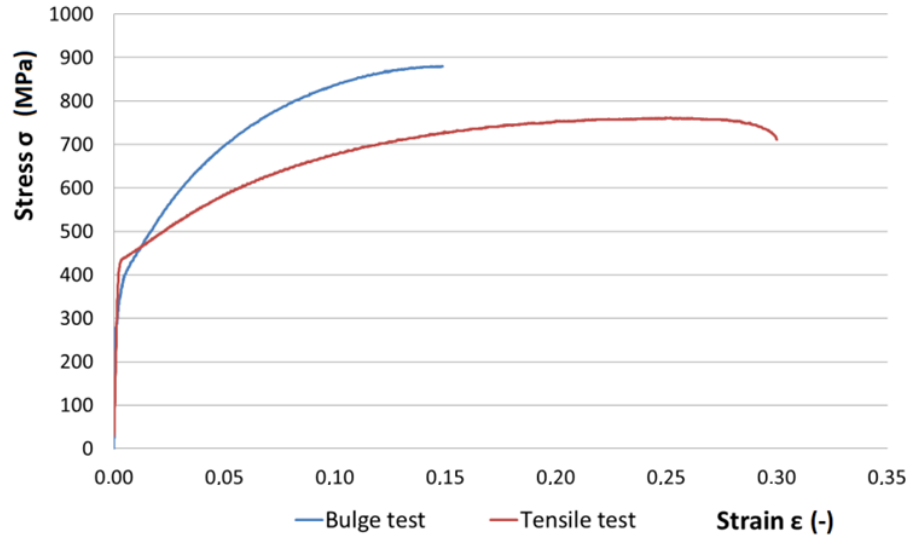
Figure 7. Stress – strain dependence from the uniaxial tensile test and the bulge test. Figure 7. Stress–strain dependence from the uniaxial tensile test and the bulge test.